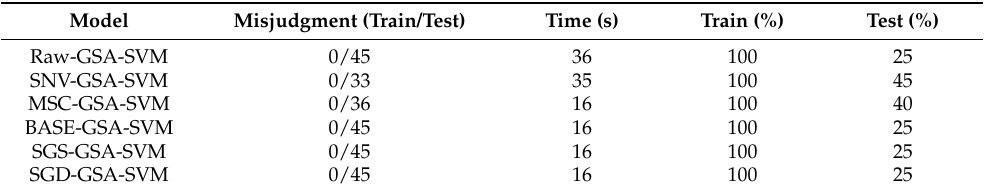
Table 4. The GSA-SVM classification models established by the original Ranman spectra and the Ranman spectra after after five different kinds of pretreatments.